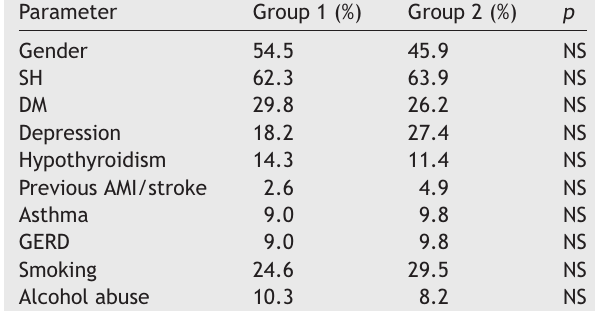
Figure 2 Correlation between average hours of CPAP use